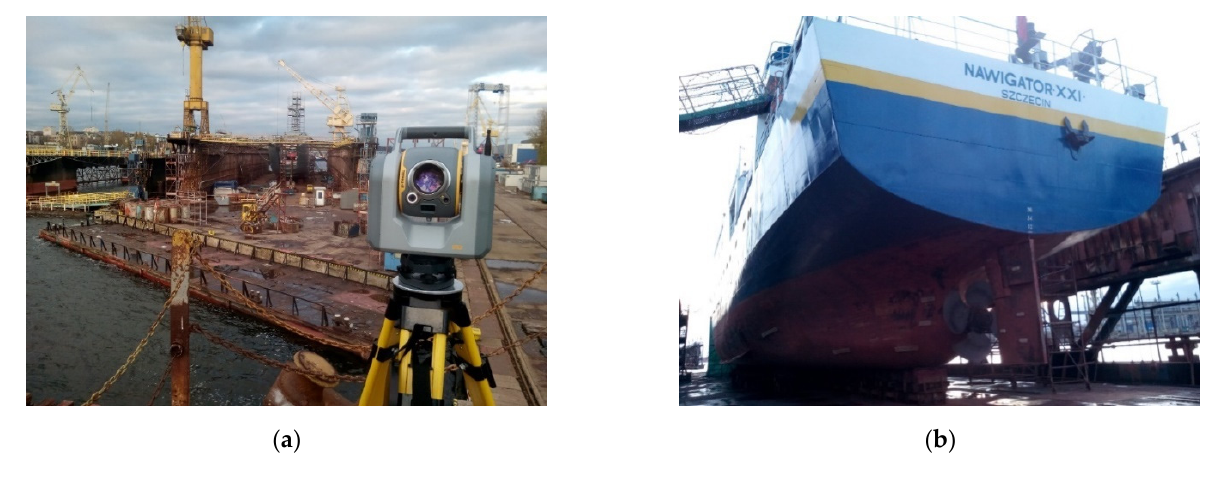
Figure 3. Total Free Station (TFS) measurements in a dock on the water, ( a ) total station on the floating dock, ( b ) vessel Nawigator XXI–measured object. dock, ( b ) vessel Nawigator XXI–measured object.